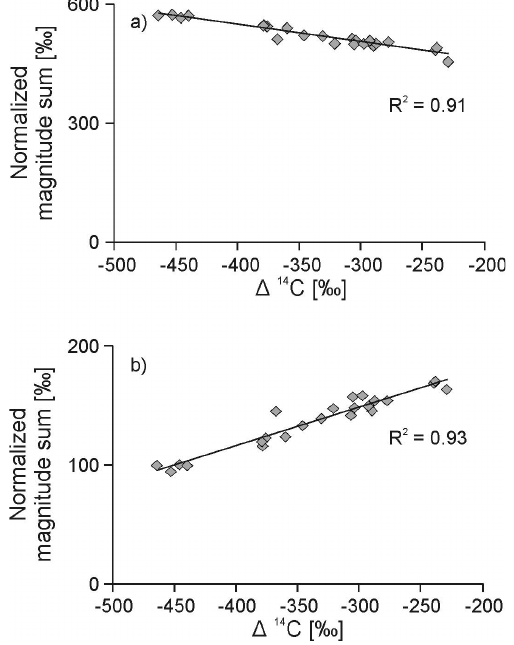
Fig. 4. Normalized magnitude sum [‰] of (a) negatively and (b) positively correlated FT-ICR mass peaks of eastern Atlantic Ocean SPE-DOM versus 1 14 C values of the SPE-DOM. The sums ( P NEG, P POS) were built by adding the normalized magnitudes of the single with 1 14 C highly negatively or positively correlating mass peaks for each sample.